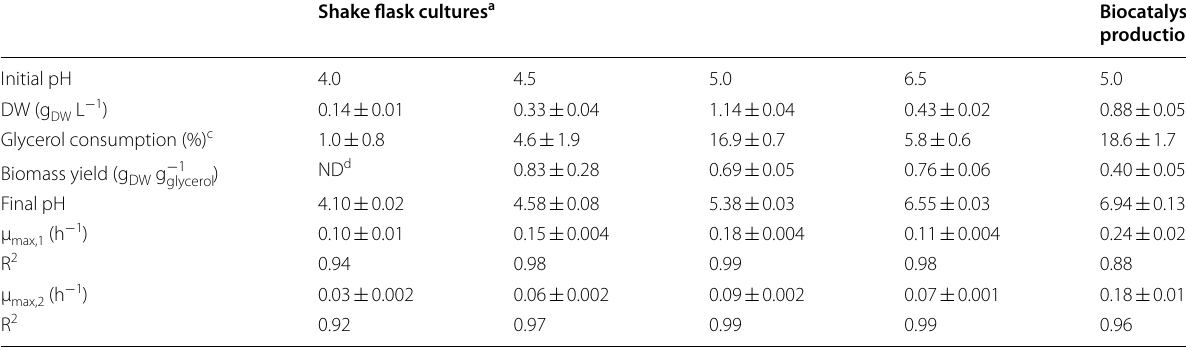
a Comparison at 30.5 h of culture